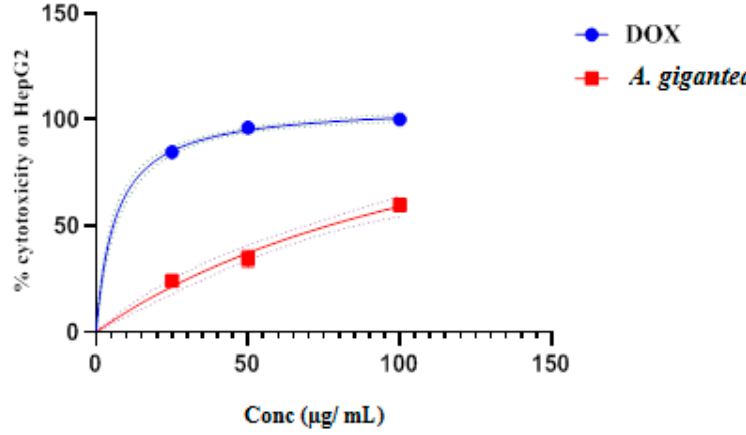
Figure 2. In vitro cytotoxic activity of A. gigantea leaf defatted methanolic extract at different concen- trations (100, 50, and 25 µg/mL) in comparison to standard drug doxorubicin.